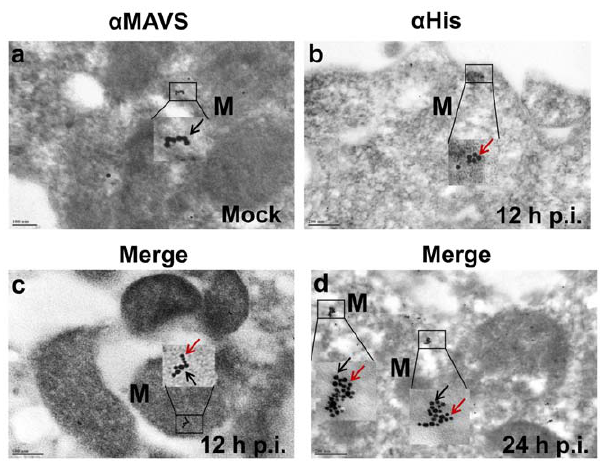
Figure 3. Colocalization of NS1 with MAVS by using immuno- gold electron microscopy. A549 cells were mock-infected or infected with 0.5 MOI rA2-His 6 -NS1 for 1 h. Cells were harvested at 12 and 24 h post-infection and processed for immunogoldelectron microscopy. Thin sections on nickel grids were treated with rabbit anti-MAVS antibody (1:100 dilution) for 3 h at room temperature, washed and then stained with 15 nm gold-labeled anti-rabbit secondary antibody. The grids were washed thoroughly and treated with a 1:20 dilution of 5 nm gold-Ni-NTA (Molecular Probes) that binds to His tags. Cells infected with rA2-His 6 -NS1 were stained for His-NS1 with 5 nm gold (red arrow) and for MAVS protein on mitochondria with 15 nm gold (black arrows). ( a ) Ultrathin sections of uninfected cells showing the 15 nm gold staining of MAVS protein (black arrow). ( b ) Ultrathin sections of infected cells 12 h p.i. showing His 6 protein stained using 5 nm gold-Ni-NTA. The inset shows His 6 -NS1 localized on the mitochondria. ( c & d ) Sections of cells 12 and 24 h p.i. showing colocalization of NS1 with the MAVS protein. Insets (1 & 2) show colocalization of NS1 (red arrow) and MAVS (black